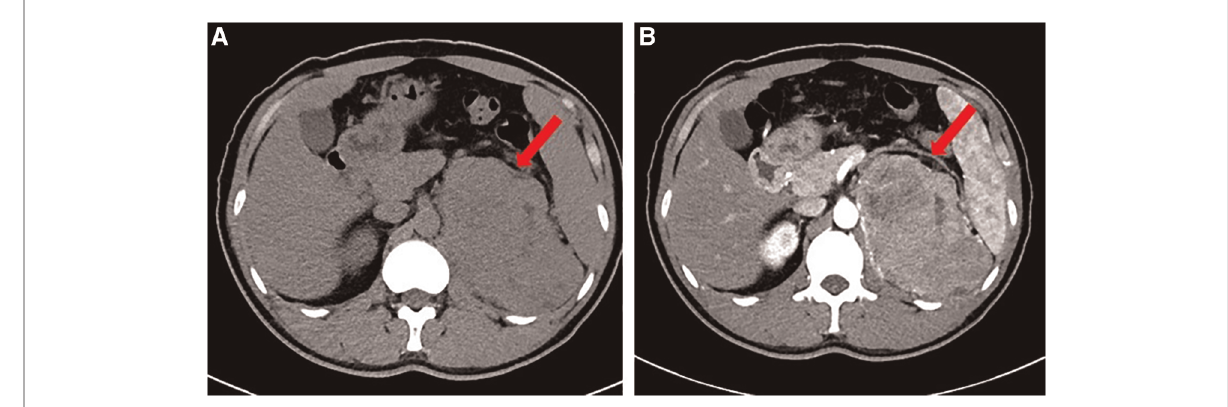
FIGURE 1 Computed tomography (CT) scan of the abdomen. ( A ). Non-Contrast CT. ( B ). Contrast CT.